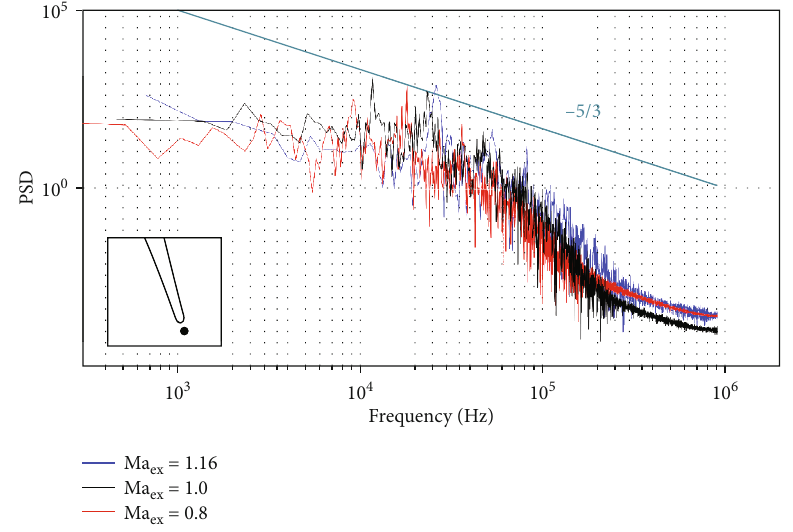
Figure 23: Turbulent velocity power spectral density of the CNRC cascade.